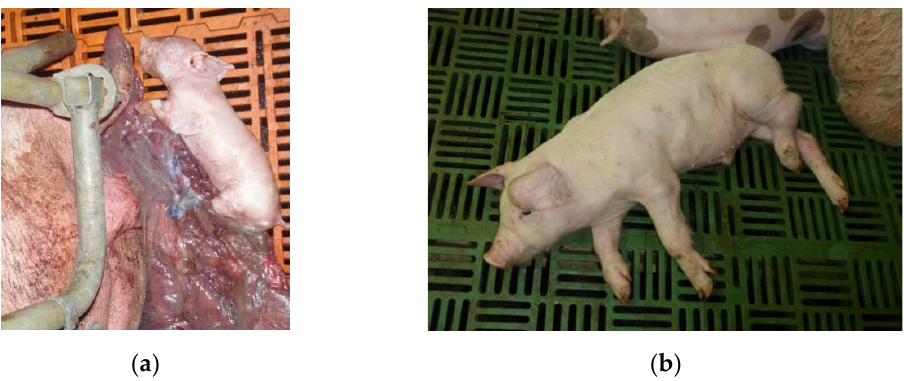
Figure 1. PRRS affected pigs on the farm of isolate GER18 ‐ 258. ( a ) Stillborn piglet ( b ) Pig with swollen joints.